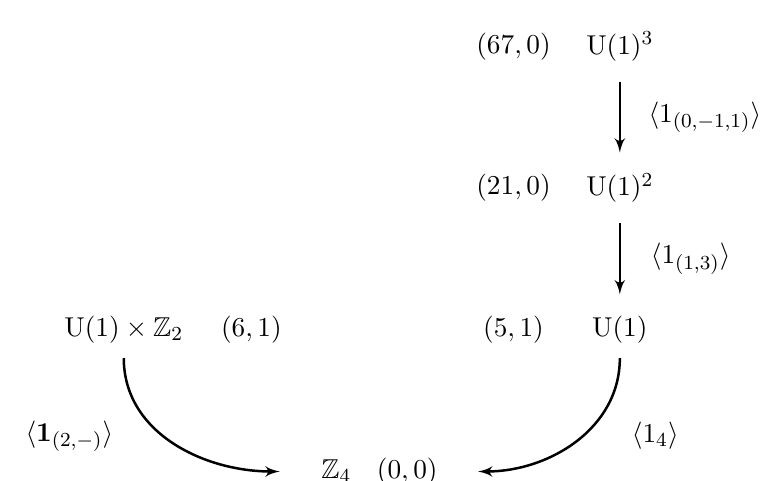
Figure 7 . Depiction of the two Higgs branches towards the Z 4 genus-one model. Gauge groups and Higgs multiplets are highlighted, together with the nef partition that engineers the